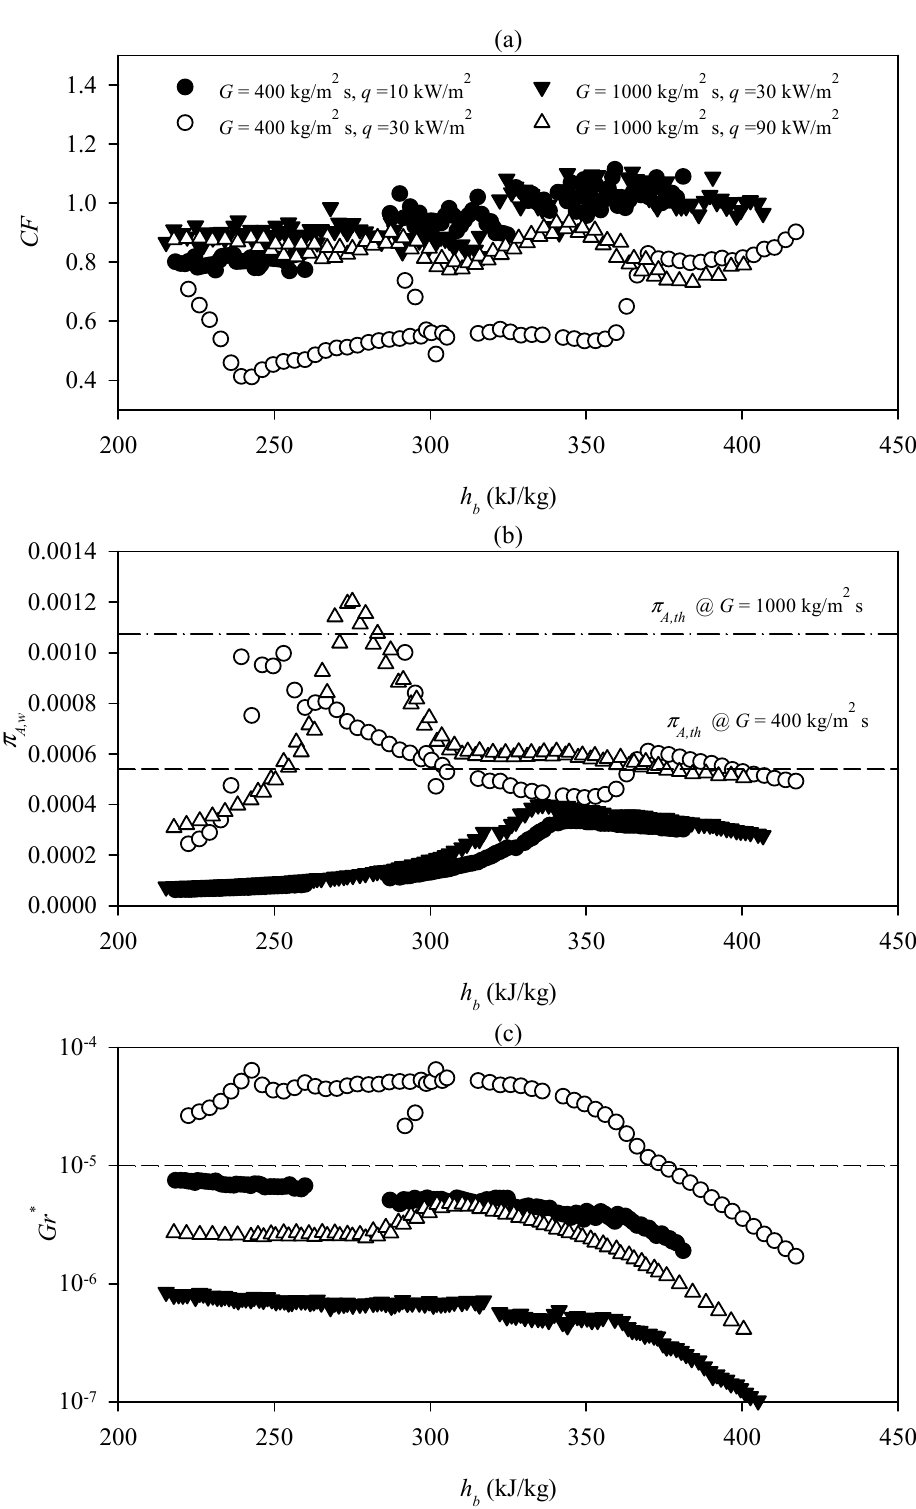
Figure 9. ( a ) CF proposed by Watts and Chou [18], ( b ) π A at wall condition, and ( c ) Gr ∗ against enthalpy for R-22